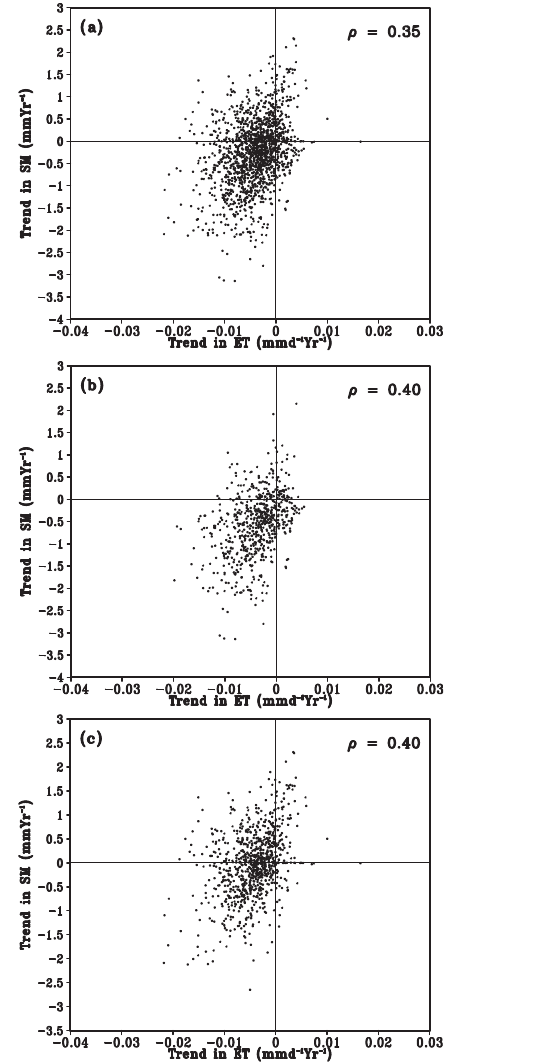
Figure 8. (a) Scatter plot of linear trends in JJAS mean evapotran- spiration (ET) during the 55-year (1951–2005) period as a function of the linear trends of total soil moisture (SM) for all the grid points over the region 70–90 ◦ E; 10–28 ◦ N. ( b and c ) same as (a) expect for the grid points with trends in surface downward short wave ra- diation (b) increasing and (c)